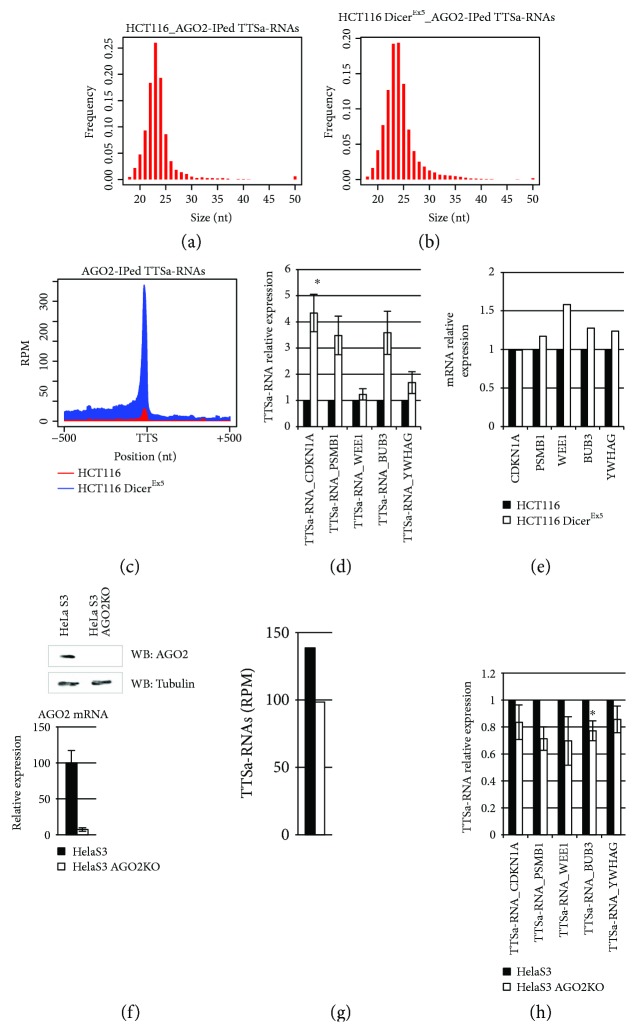
TTSa-RNA biogenesis is independent of both DICER and AGO2. (a) Size distribution of AGO2-immunoprecipitated TTSa-RNAs from HCT116 and HCT116 DicerEx5 (b) nuclear lysate. (c) Coverage of AGO2-bound TTSa-RNAs around GENCODE v25 annotated human TTSs in parental HCT116 (in red) and HCT116 DicerEx5 subclone (in blue). (d) qPCR analysis of selected TTSa-RNAs in parental HCT116 and HCT116 DicerEx5 subclone (n = 4). RNU44 was used for normalization. (e) Microarray analysis (GEO dataset GSE6427) of the CDKNA1, PSMB1, WEE1, BUB3, and YWHAG mRNA expression in parental HCT116 and HCT116 DicerEx5 subclone. (g) Abundance (RPM) of TTSa-RNAs in sRNA libraries generated from whole cell extract of parental HelaS3 and AGO2KO cells. (h) AGO2 has been genetically knocked out (AGO2KO) in HeLaS3 cells by using specific Zinc Finger Nucleases. In these cells, AGO2 is undetectable at protein level (upper panel) and strongly reduced at mRNA level (lower panel). (f) qPCR analysis of selected TTSa-RNAs in parental HeLaS3 and HeLaS3 AGO2 KO subclone (n = 5). RNU44 was used for normalization. qPCR data are expressed as mean ± SEM. (∗
p value ≤ 0.05; paired t test).